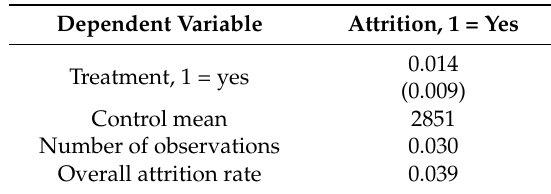
Table A1. Attrition check.